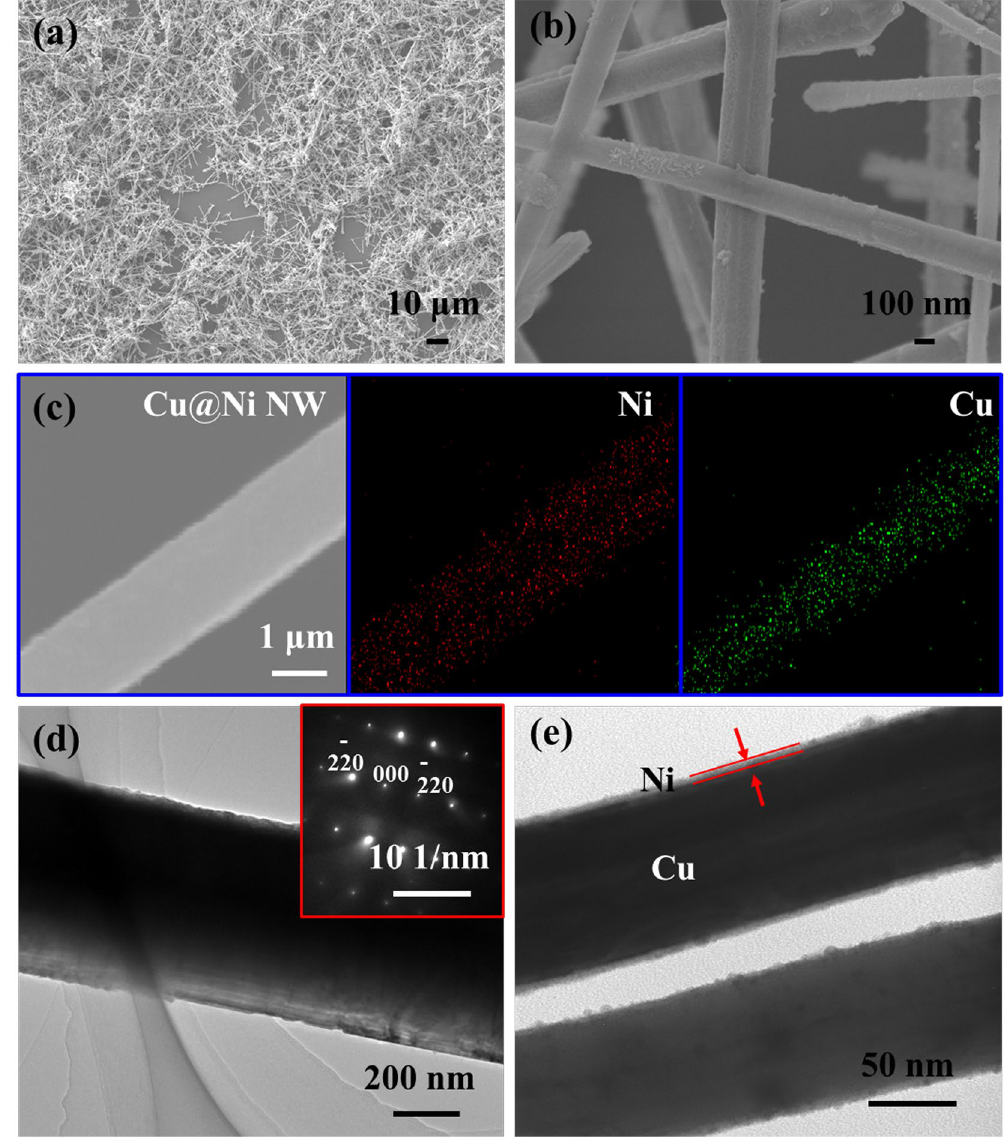
Figure 3. ( a , b ) SEM images of Cu@Ni NWs with different magnifications. ( c ) Cu@Ni NW and corresponding elemental mapping images of Ni and Cu. TEM images of Cu NW ( d ) and Cu@Ni NWs ( e ). The inset of Fig. 3(d) is the SAED pattern of Cu